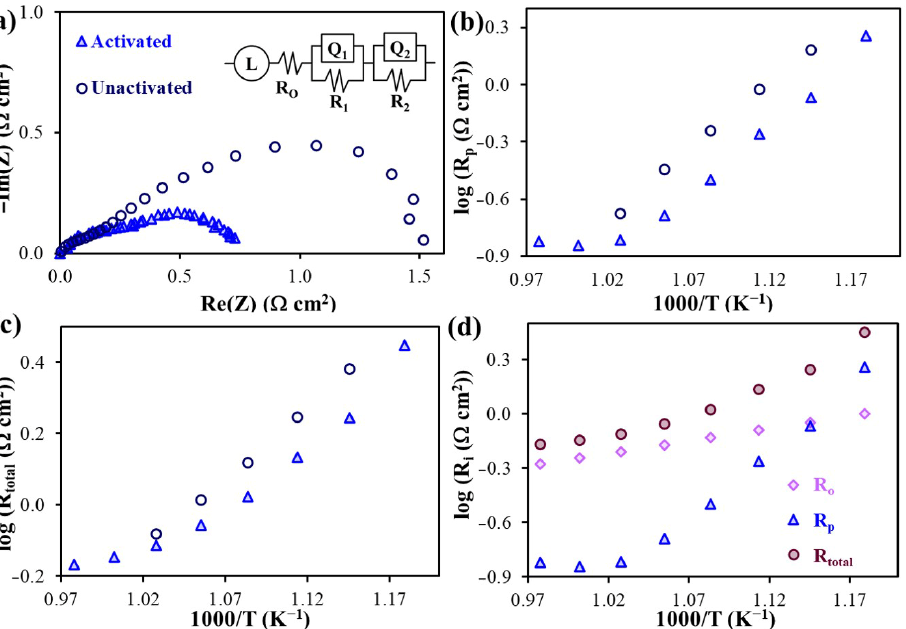
Figure 12. Impedance spectra of single PCFCs with BCZYF0.6 cathode before and after electroacti- vation ( a ), comparison of polarization ( b ) and total ( c ) resistances of single cells, partial resistances of electrochemical cell with cathode modified with PrO x nanoparticles ( d ).